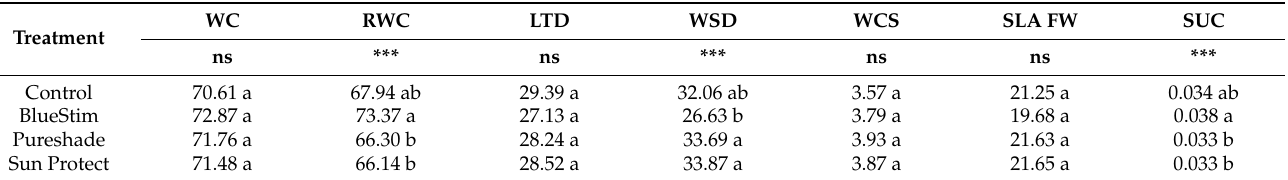
Table 1. Effects of the alleviating products on kiwifruit leaf sclerophylly indexes during the first sampling event on August 7th (WC, %; RWC, %; LTD, g kg − 1 ; WSD, %; WCS, g H 2 O g − 1 DW; SLA